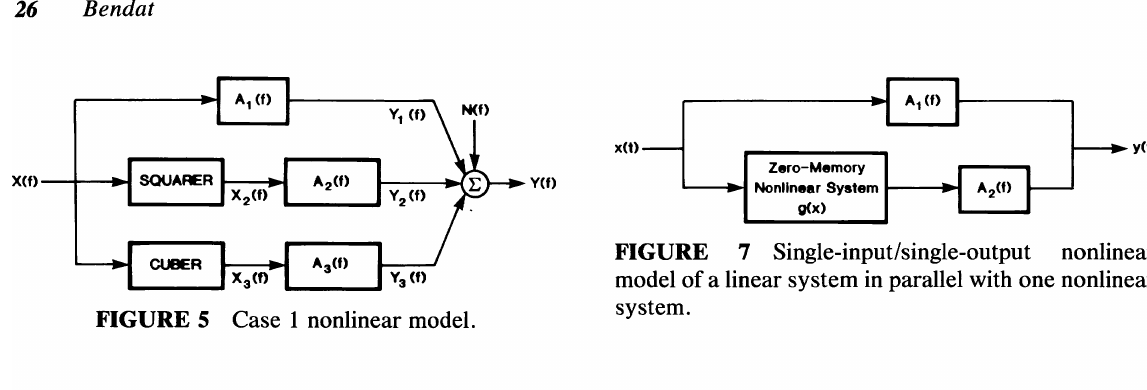
FIGURE 5 Case 1 nonlinear model.